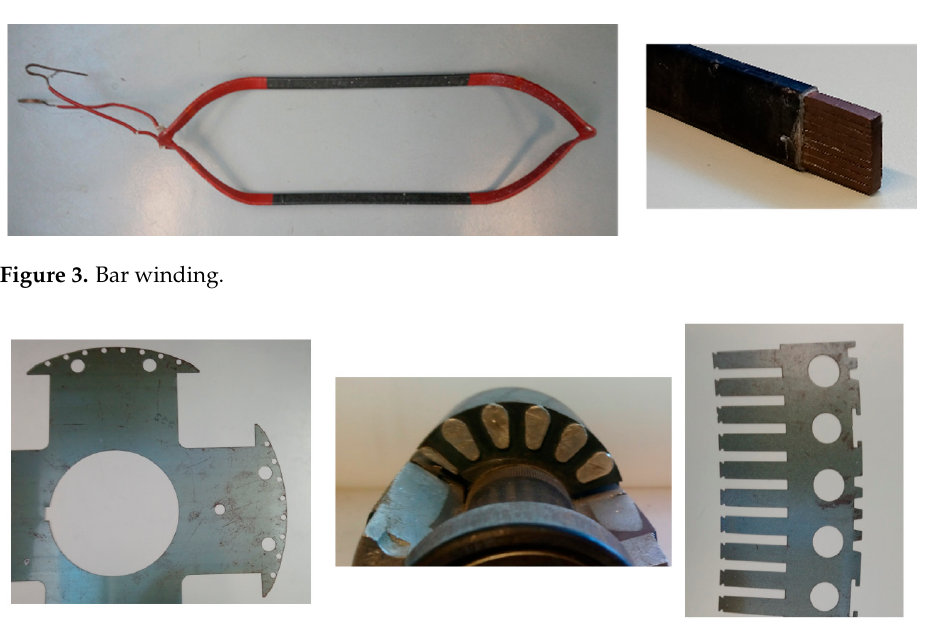
Figure 4. Example of sheet metal with slot for bar conductor.